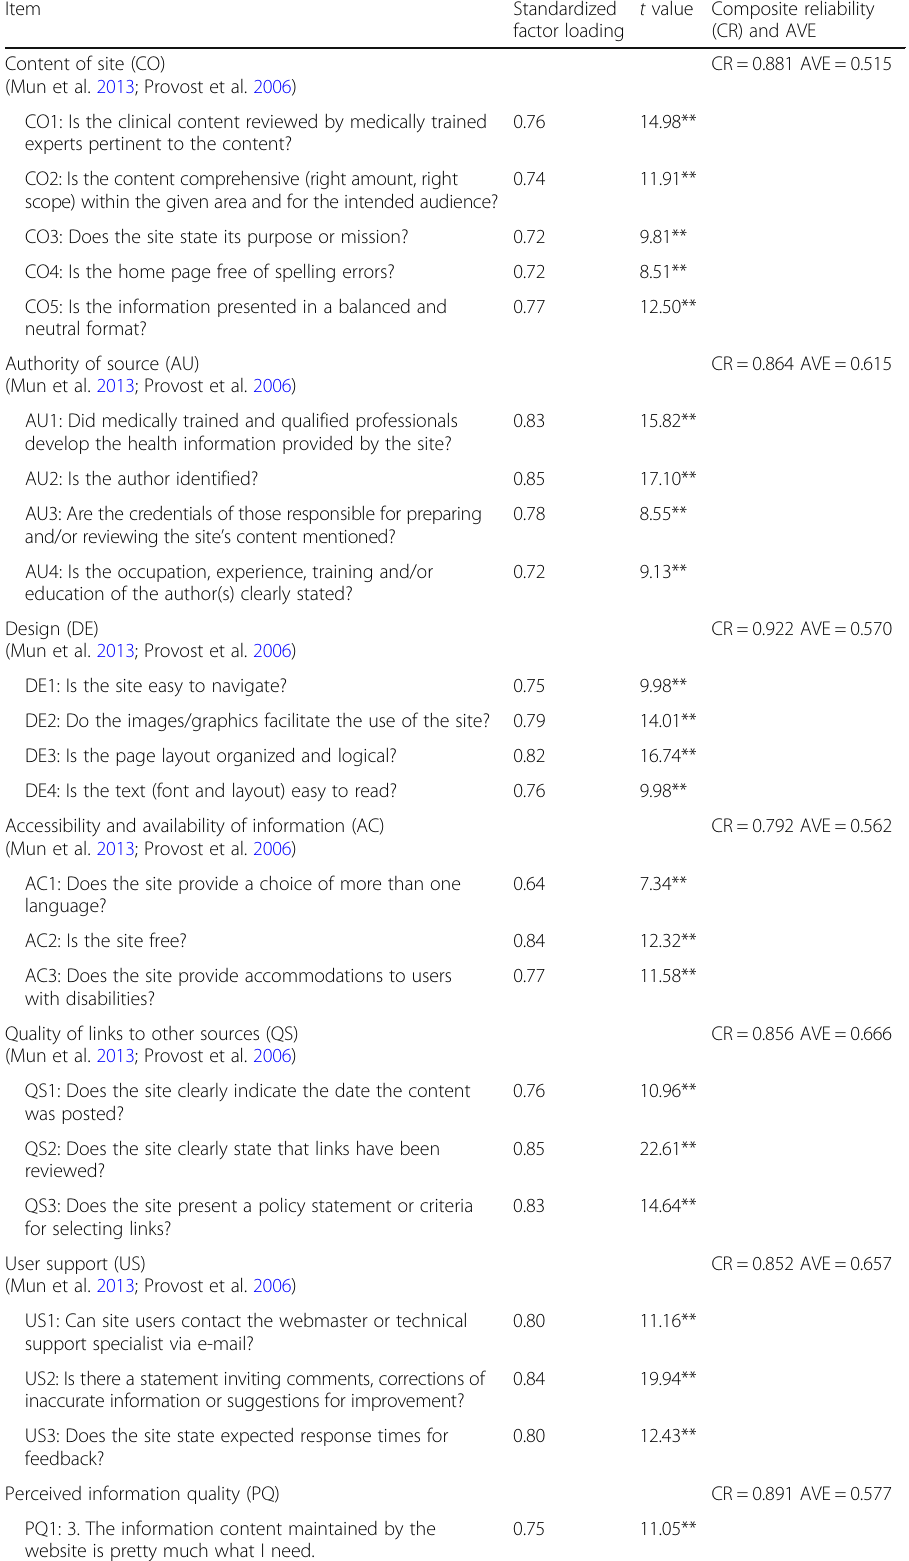
Table 2 Reliability assessment of the measurement